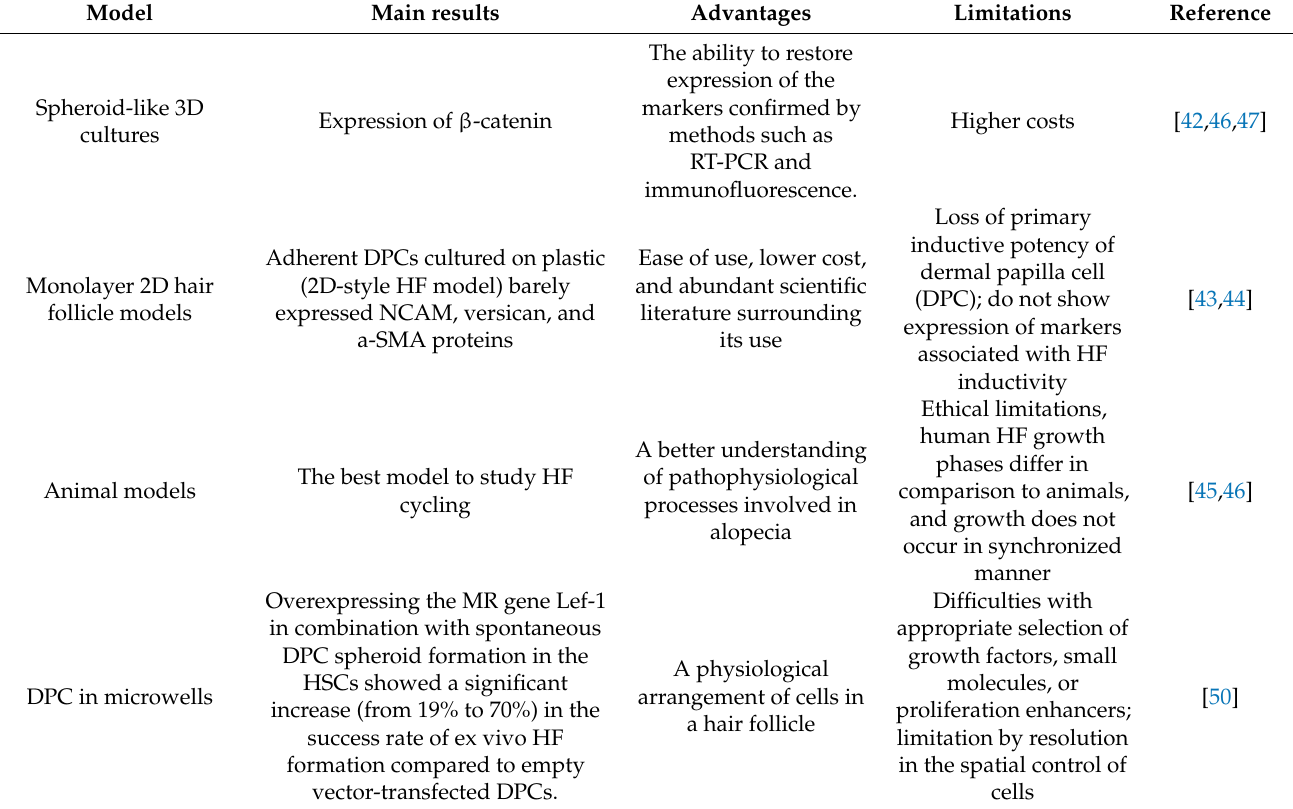
Table 1. Table of established in vitro models for hair follicle